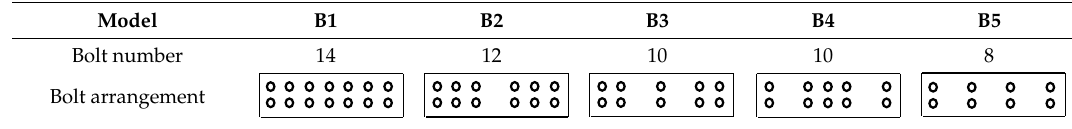
Table 5. Number and arrangement of bolts.